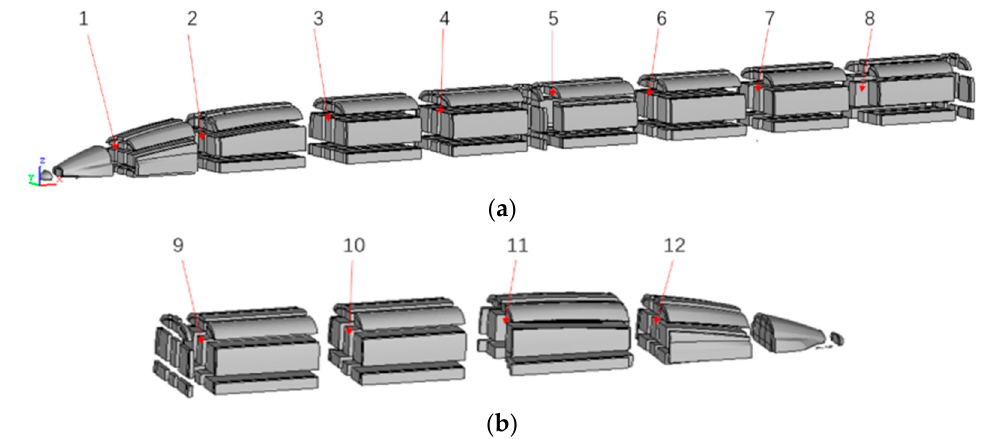
Figure 10. Number of interior acoustic cavity subsystems: ( a ) Head and middle cars, ( b ) tail car.